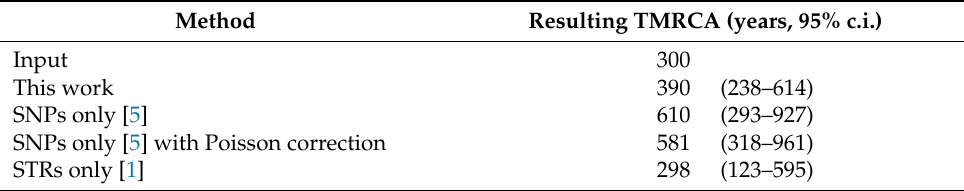
Table 2. Results for age of E. in Example 1, in the scenario where the age of D . is